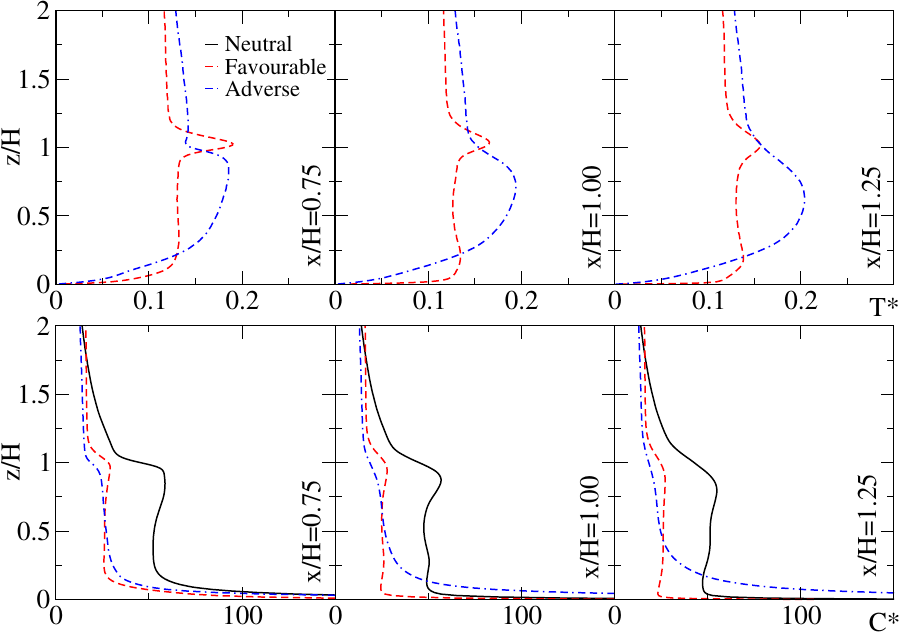
Figure 7. Non-dimensional mean temperature T ∗ = ( T − T 0 ) / ∆ T and concentration C ∗ = c / C 0 along three selected vertical lines x / H =